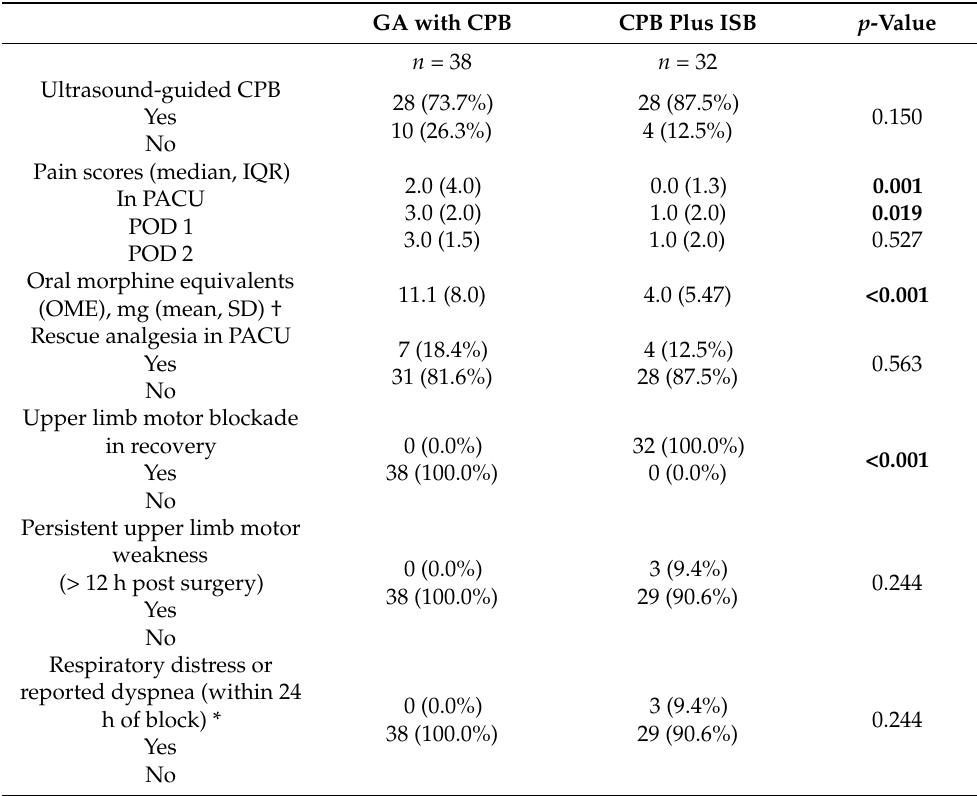
Table 3. Comparison of pain scores and opioid requirements of patients who received a cervical plexus block alone versus those who received a cervical plexus block plus interscalene brachial plexus block.